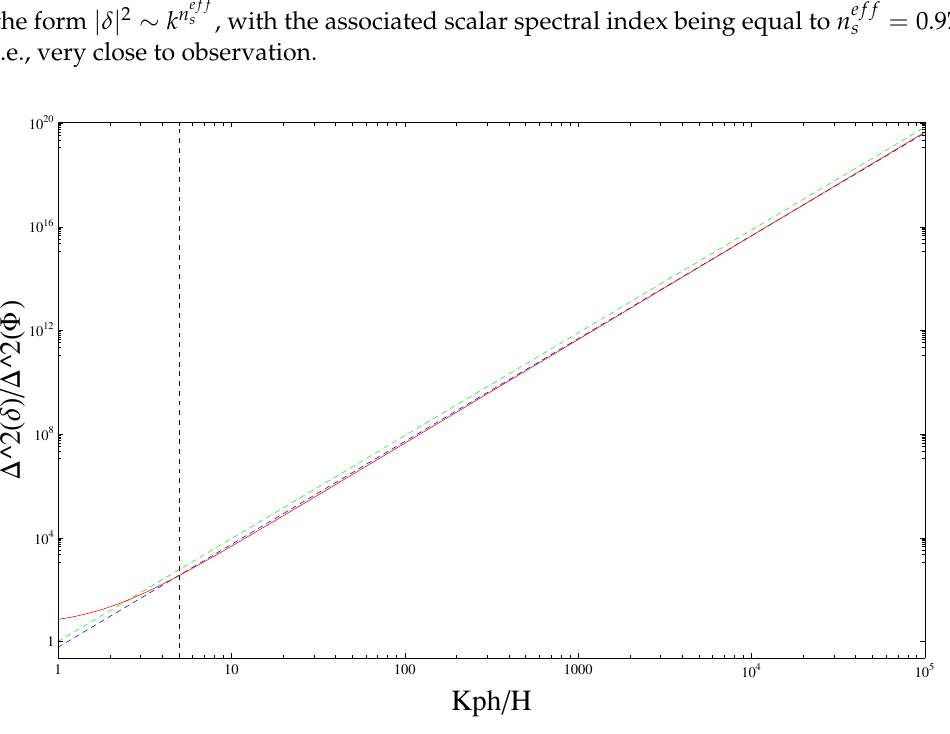
Figure 6. Small-scale perturbations, i.e., Equation (63), in the Γ = 0 limit of the polytropic DM model (red solid line). The straight dashed line of slope α = 3.970 represents Equation (64). We conclude that, in the polytropic DM model under consideration, rest-mass density perturbations of physical wavelength smaller than the Hubble radius exhibit an effective power-law behavior with a scalar spectral index equal to n ef f s =